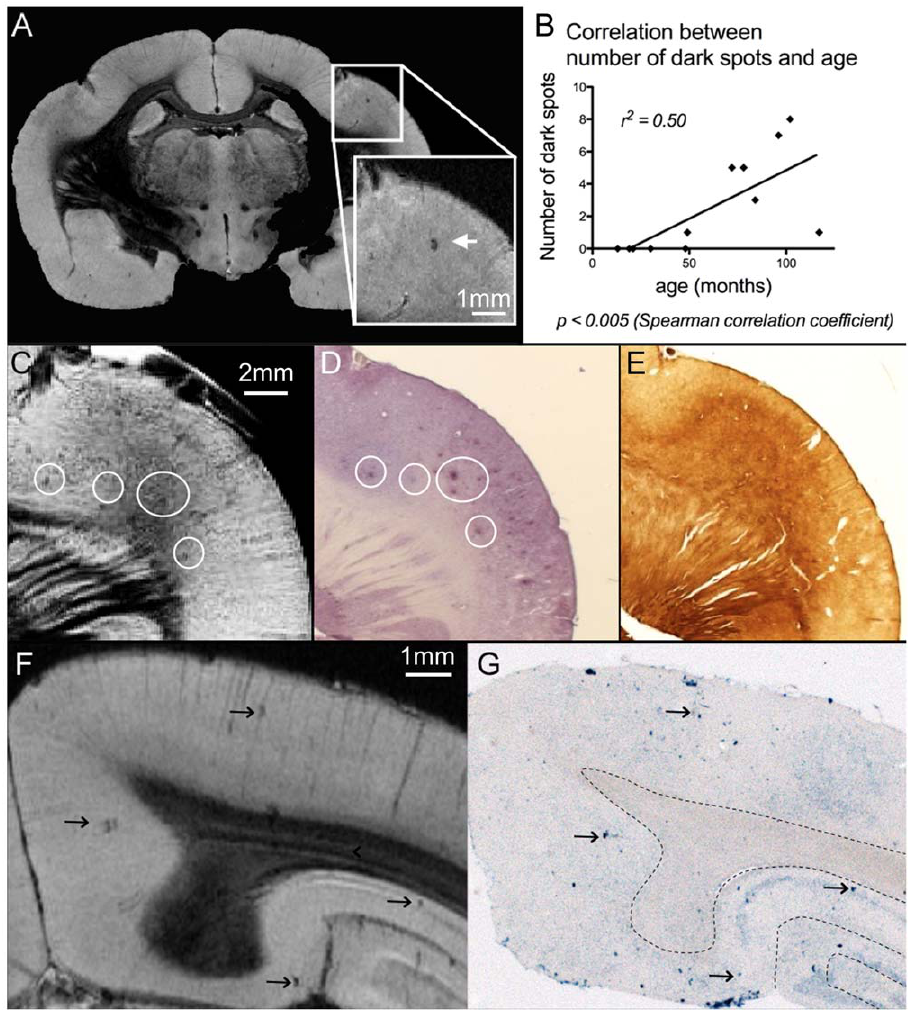
Figure 3. Detection of cortical and hippocampal black dots. (A) Example of the black dots detected in the cortex of mouse lemurs on MR images. (B) The number of black dots in each animal was significantly correlated with age (p , 0.005). In one animal, some black dots visible on MR images (C) matched the location of amyloid deposits detected by Abeta staining (D, 4G8 staining, white circles). The level of iron within amyloid deposits was similar or slightly higher than in the surrounding parenchyma (E, Perls-DAB staining). In animals without amyloid deposition, the location of black spots on MR images (F, arrows) corresponded to focal area of microhemorrhages detected by Perls staining (G, arrows).